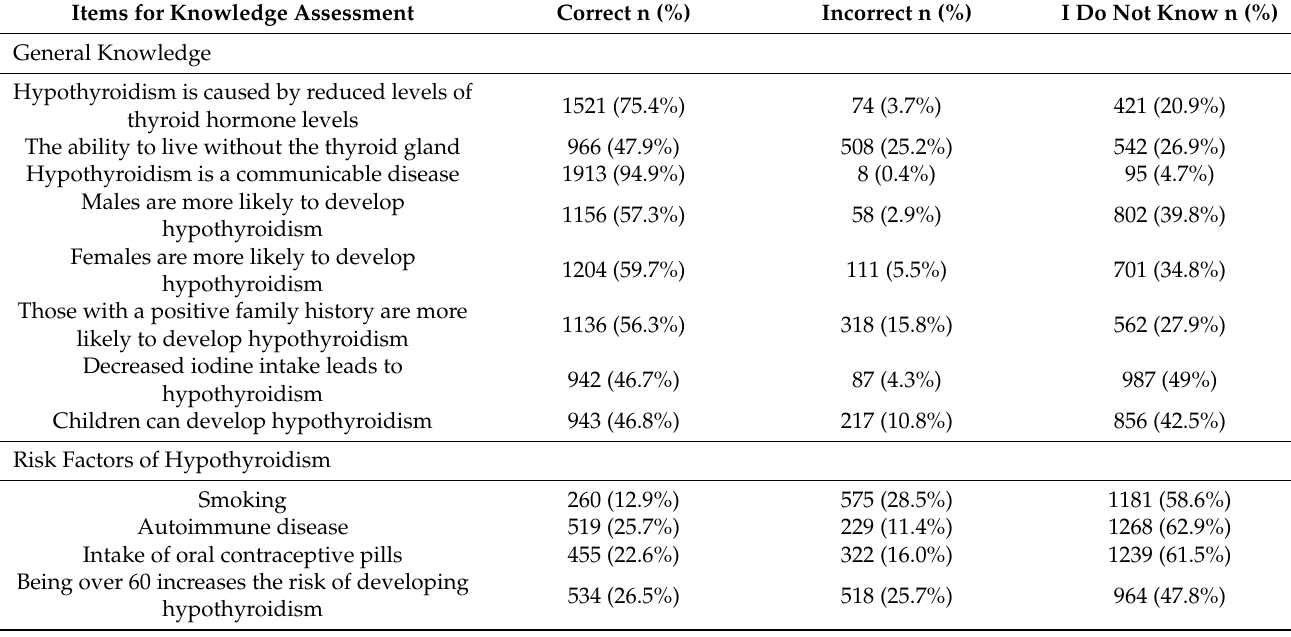
Table 2. Items for knowledge